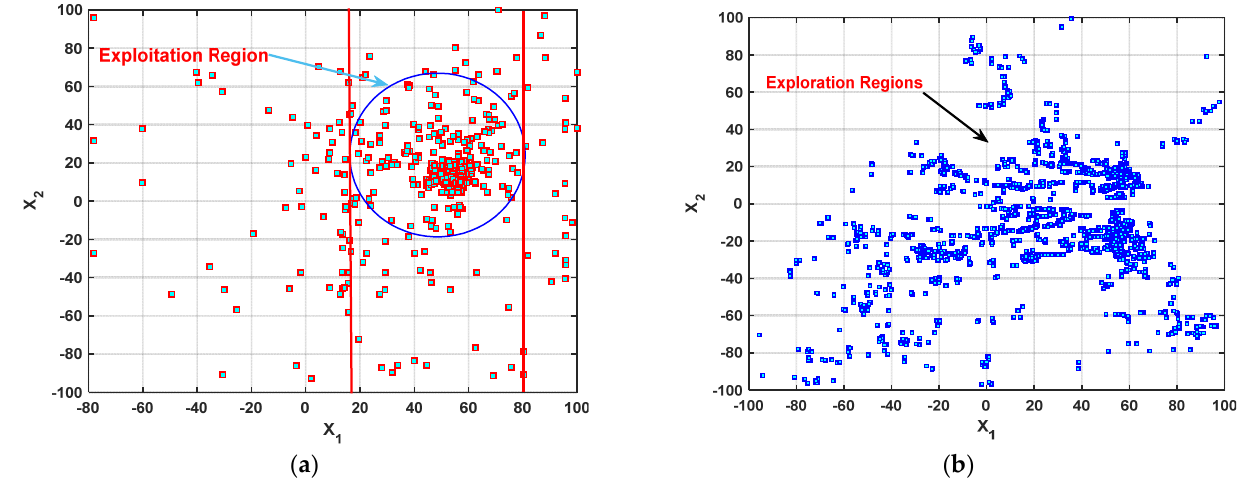
Figure 7. Depiction of exploration and exploitation stages of the proposed algorithm (LSO). ( a ) Exploitation phase. ( b ) Exploration phase.